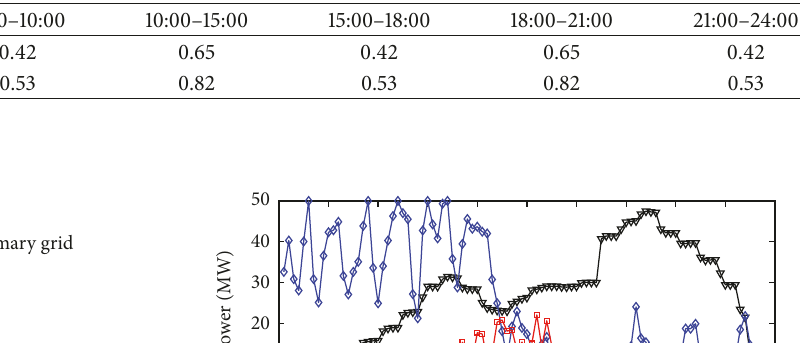
Table 4: Power prices in different times of the whole day (unit: RMB/kWh).